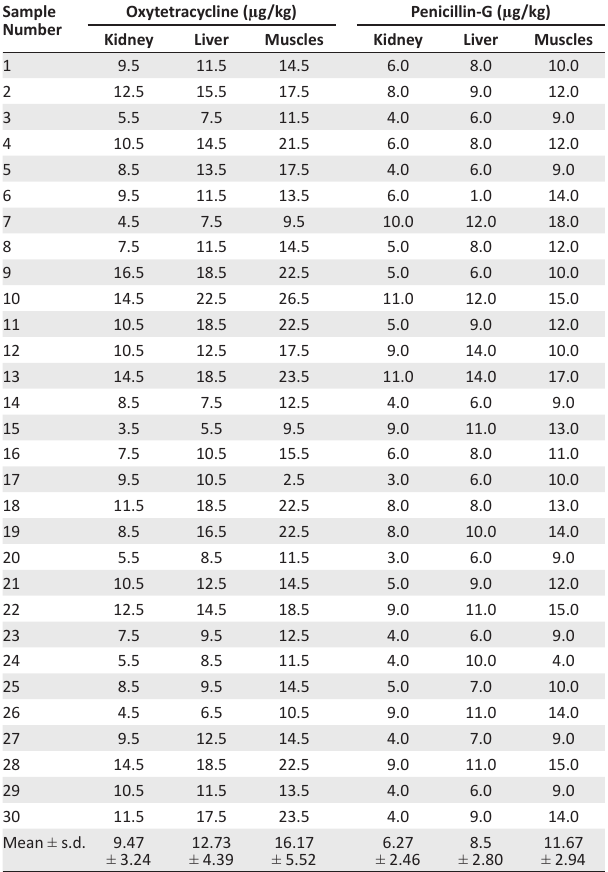
TABLE 1: Residue levels of oxytetracycline and penicillin-G in tissues of slaughtered cattle in south-western